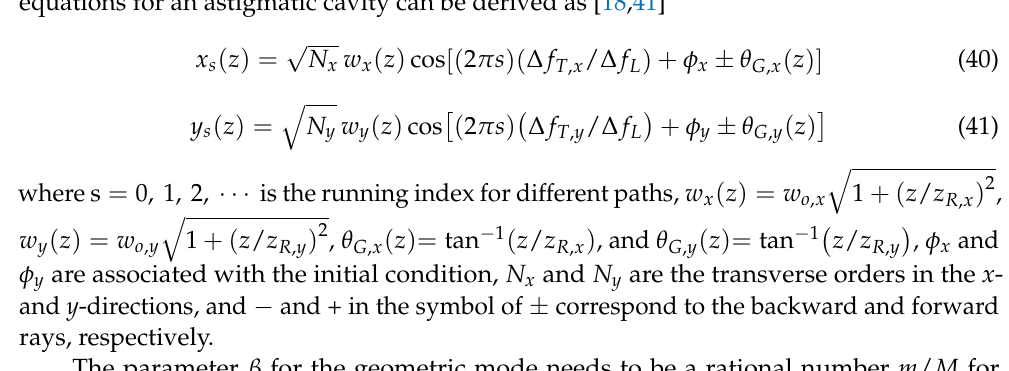
(cid:113) w y ( z ) = w o , y 1 + ( z / z R , y ) 2 , θ G , x ( z )= tan − 1 ( z / z R , x ) , and θ G , y ( z )= tan − 1 φ y are associated with the initial condition, N x and N y are the transverse orders in the x - and y -directions, and − and + in the symbol of ± correspond to the backward and forward rays,